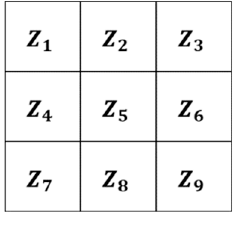
Figure 2. Coe ffi cients Z i Figure 2. Coefficients Z (cid:2919) . Figure 2. Coefficients Z (cid:2919) .